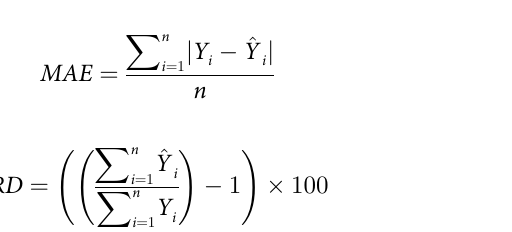
Fig 3. Scatter plot matrix showing the relationships between the variables (for the explanation of variables, please refer to Table 1).